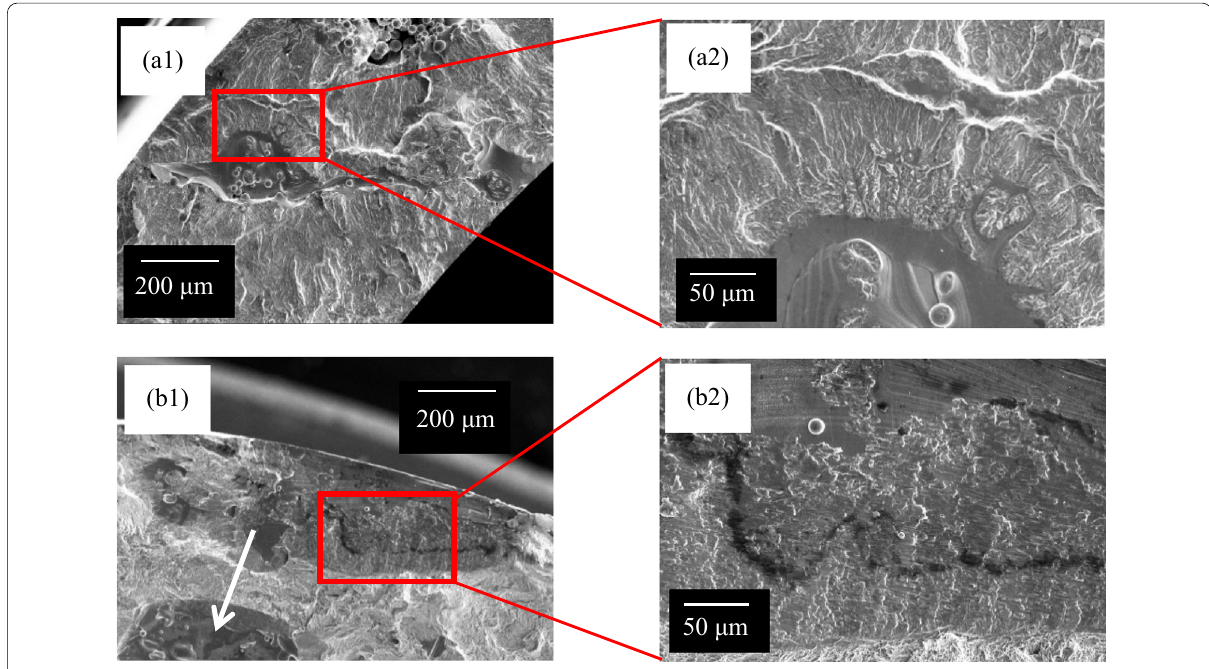
Figure 10 SEM images of the fracture surface: a push–pull strain path (PP) and b circle strain path